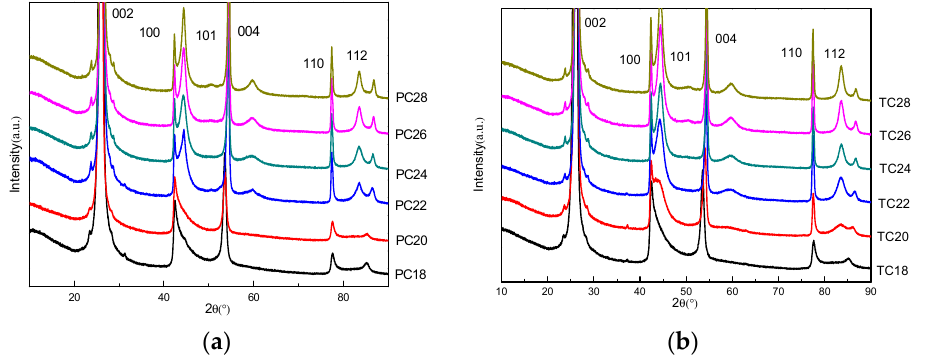
Figure 2. XRD diffraction patterns of two kinds of coke anode materials under different temperatures. ( a ) XRD diffraction patterns of petroleum coke under different temperatures; ( b ) XRD diffraction patterns of pitch coke at different temperatures. Table 2. Microcrystalline structure analysis of two kinds of coke anode materials at different temperatures.